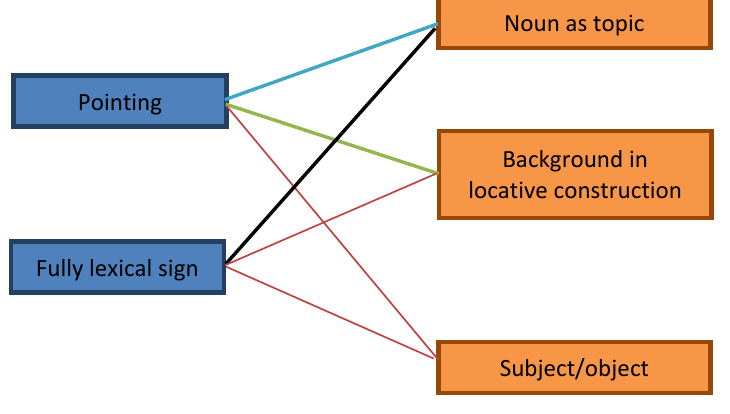
Figure 3 Relation between forms and functions of holds in RSL and NGT. The blue line represents a pointer buoy in Liddell’s terminology; the green line represents a point buoy; the black line would be characterised as a fragment buoy; the other lines are not accounted for in terms of